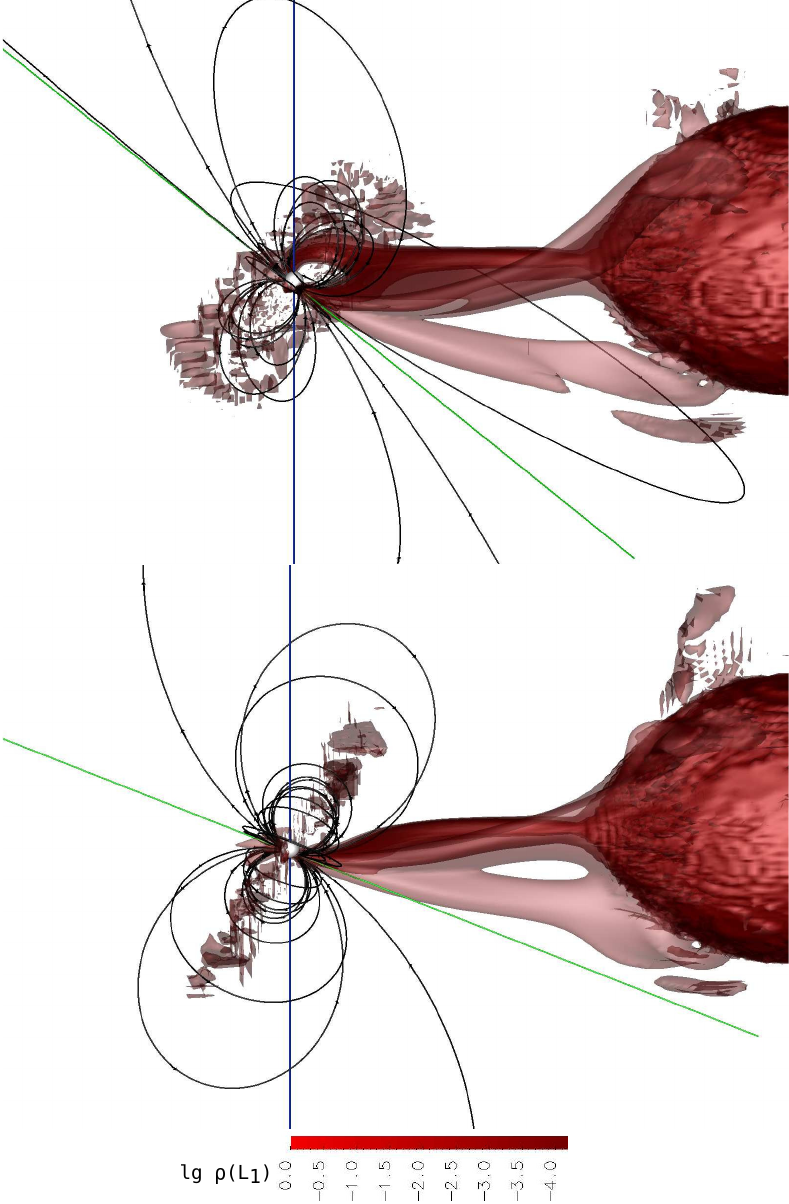
Figure 9. The same as Figure 6 but for phases 0.6 ( upper panel) and 0.7 ( lower panel). The system is shown from the point of view of an Earth observer at the orbital phase